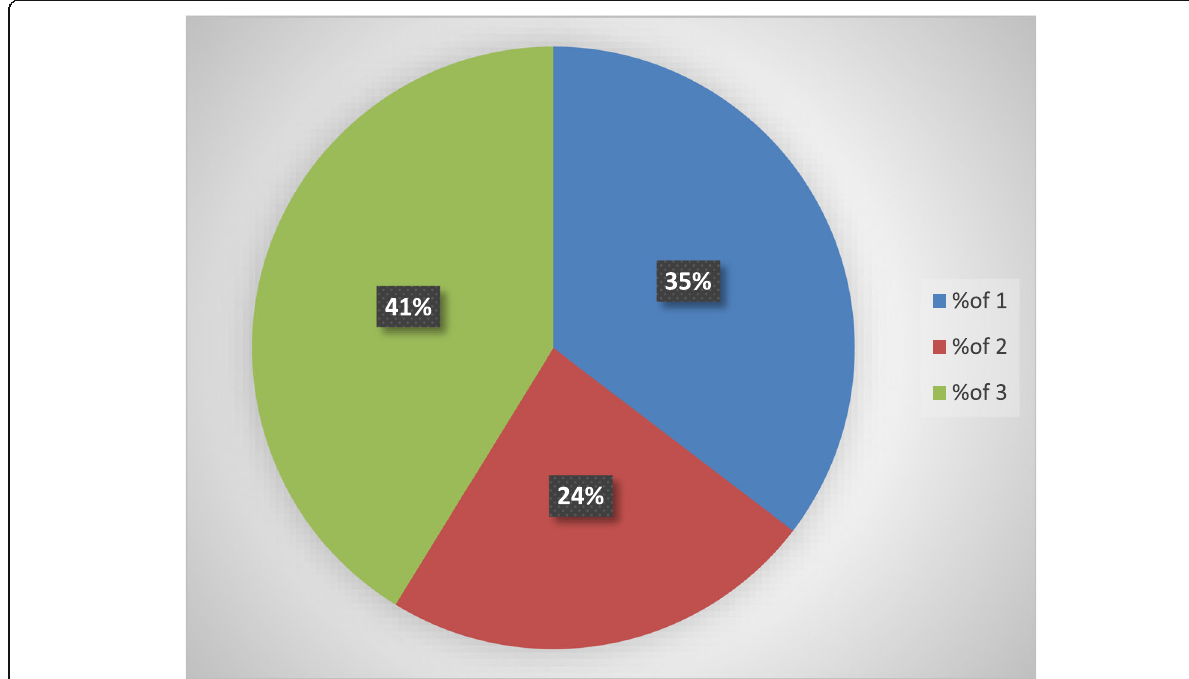
Fig. 5 Percentage of each of the three scores